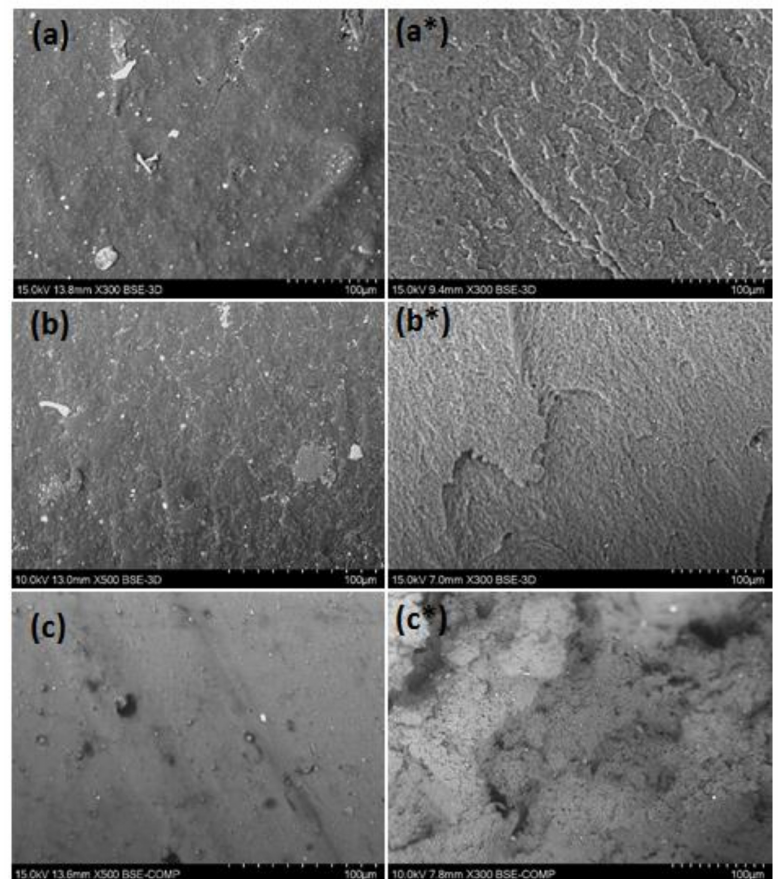
Figure 6. Scanning electron microscope (SEM) micrographs of filaments: extruded side surface of rPS ( a ) rABS ( b ) and rPVC ( c ) ( × 300 or 500) and fractured surfaces of rPS ( a* ), rABS ( b* ) and rPVC ( c* ) ( ×